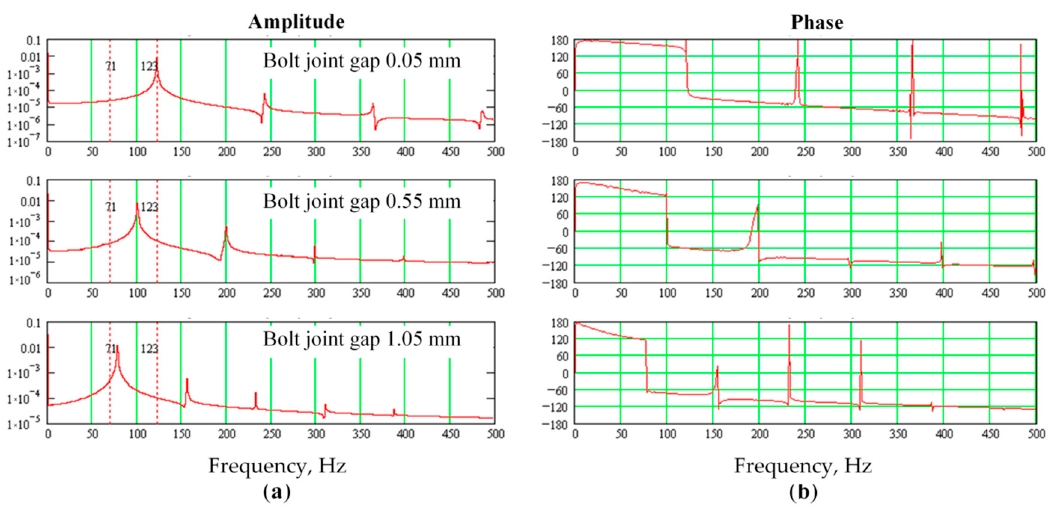
Figure 9. Amplitude ( a ) and phase ( b ) of shaft vibration depending on the opening of the bearing bolted joint.